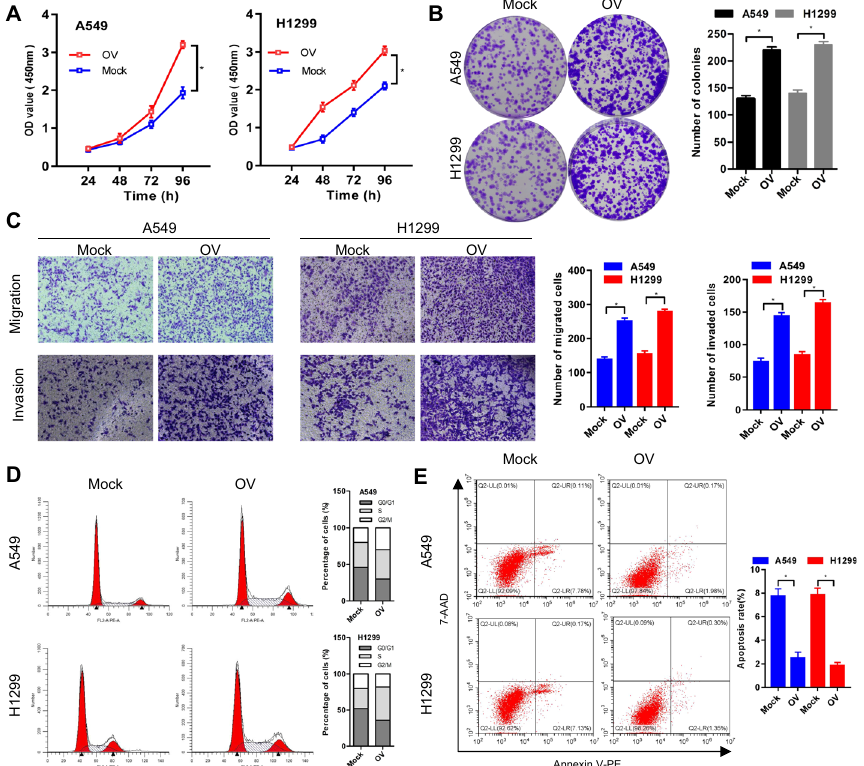
Fig. 5 GALNT2 overexpression promotes malignant phenotypes of NSCLC cells. A CCK-8 assay. B Colony formation assay. C Transwell migration and Matrigel invasion assays (magnification, analysis of cell cycle. E Analysis of cell apoptosis by flow cytometry. OV GALNT2 overexpression lentivirus, Mock normal control lentivirus. * P < 0.05